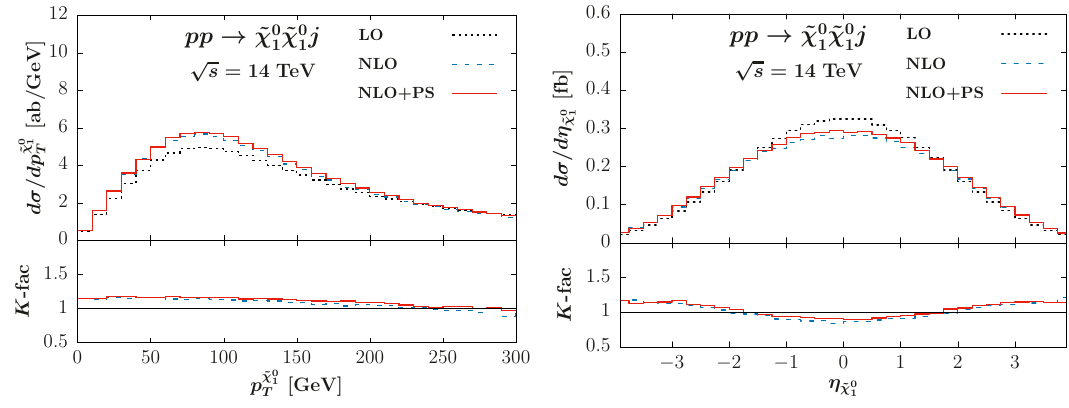
0 (left) and pseudo-rapidity (cid:17) 1 T ~ (cid:31) 0 ~ (cid:31) 0 j at LO (dotted black lines), NLO (dashed blue 1 1 !